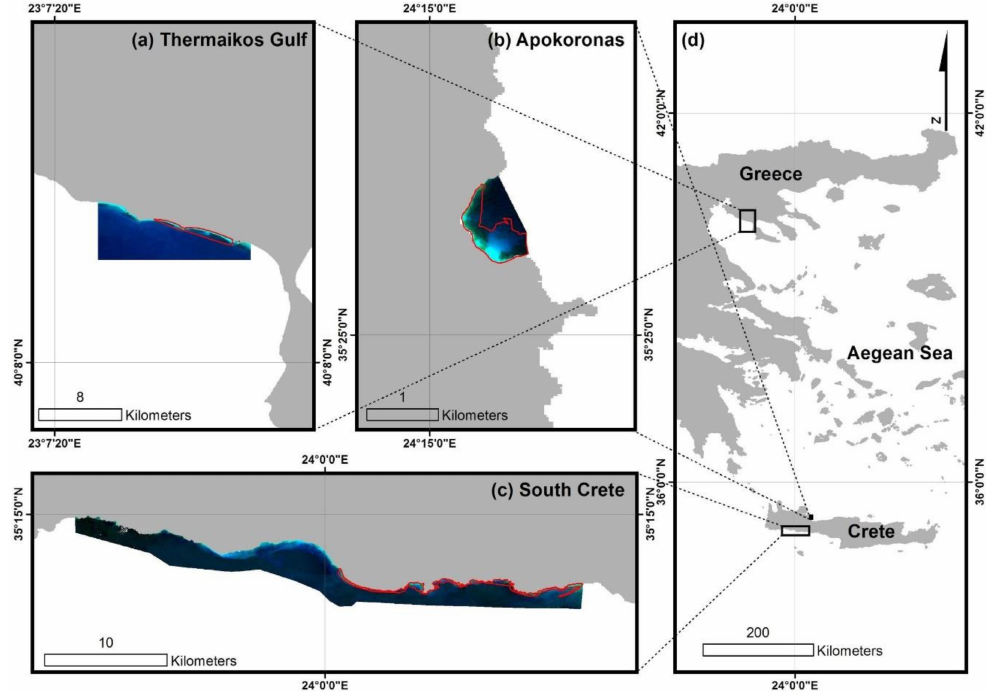
Figure 1. Locations of selected study sites for bathymetry model analysis: ( a ) Thermaikos Gulf; ( b ) Obros Gyalos in the Apokoronas area; ( c ) National Samaria Park, South Crete; and ( d ) the Aegean Sea, Greece. The red polygons indicate the extent of the area that is used for the actual analysis. All depicted images are median Sentinel-2 composites using the preprocessing workflow from Figure